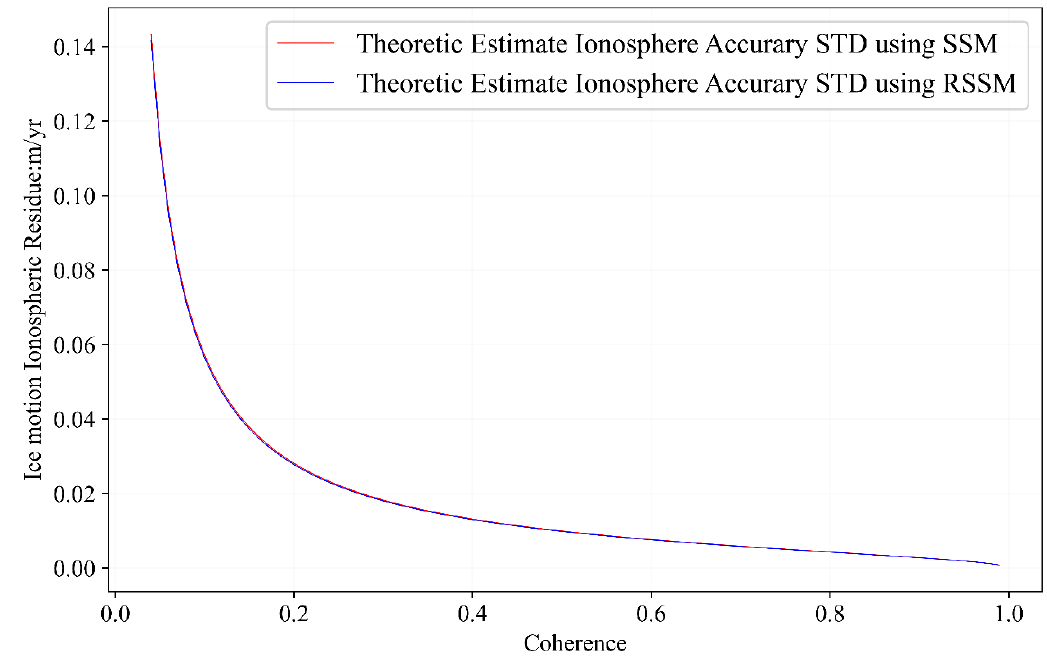
Figure 1. Comparison of the theoretical residuals between RSSM and SSM estimates of ionosphere ice motion. The X-axis is the interferometric coherence, while the Y-axis is the ice motion residue.